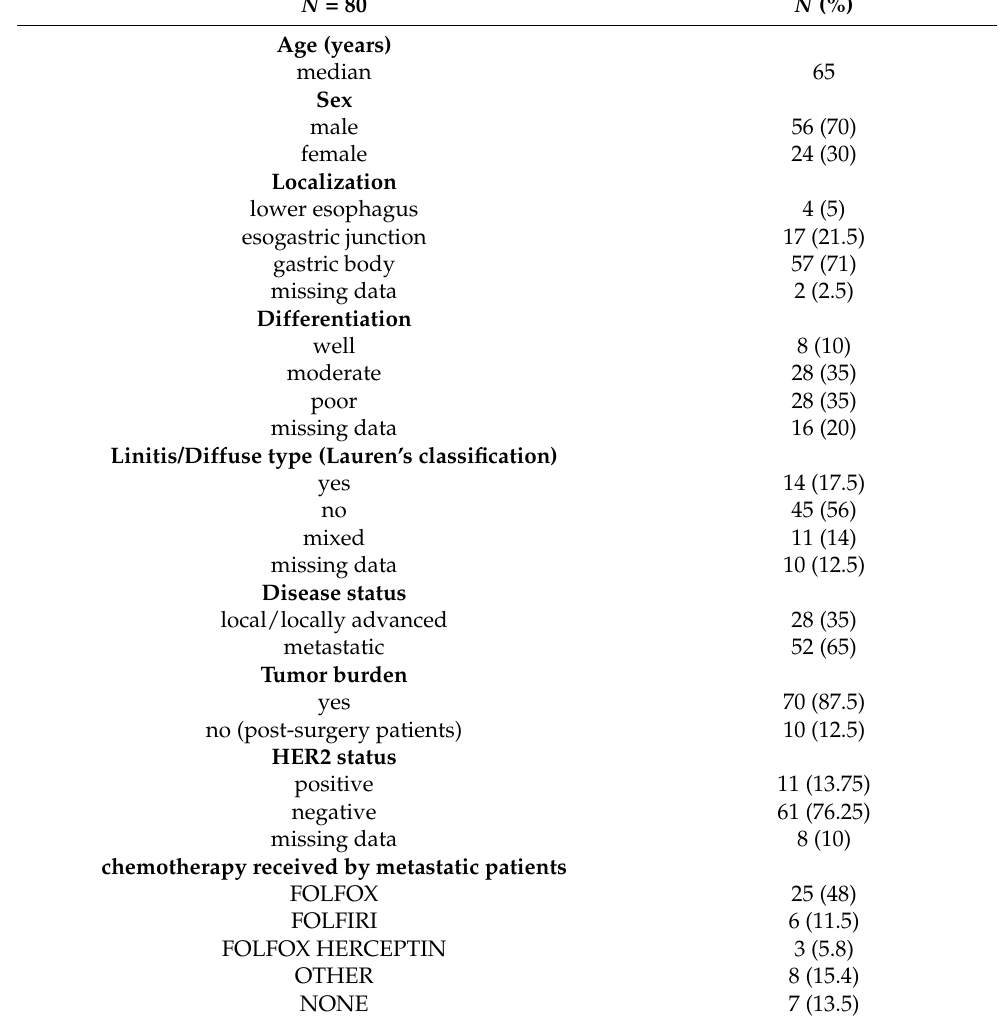
Table 2. Characteristics of patients from the PRODIGE17-ACCORD20-MEGA ancillary